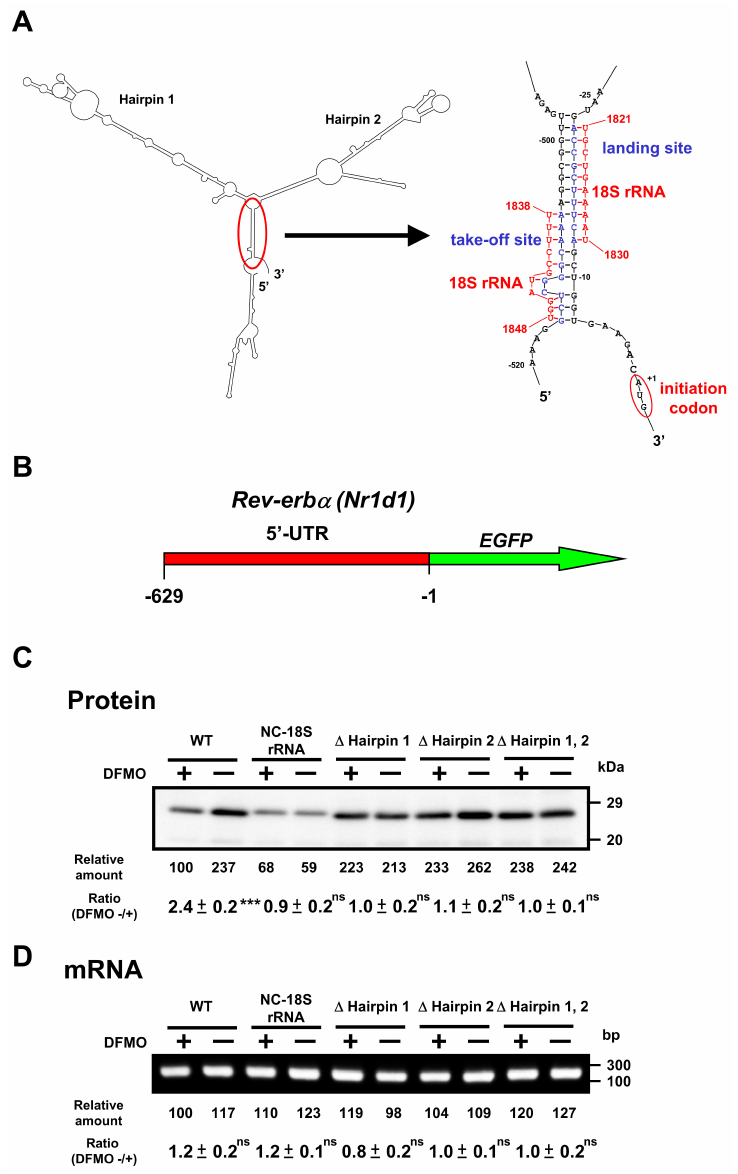
Figure 6. Effect of polyamines on the synthesis of REV-ERB α -EGFP derived from normal and modified Rev-erb α -EGFP mRNAs in NIH3T3 cells. Experiments were performed as described in the legend to Figure 5. ( A ) Optimal computer folding of the 5 (cid:48) -untranslated region (UTR) of Rev-erb α mRNA was performed by the method of Zuker [26]. Candidates for take-off and landing sites, which are complementary sequence to 18S rRNA are shown in blue, together with the sequence of 18S rRNA in red. ( B ) Structures of Rev-erb α -EGFP fusion genes are shown. ( C , D ) The levels of protein and mRNA were measured by Western blotting and RT-PCR, respectively. Rev-erb α -EGFP fusion gene encoding normal and modified 5 (cid:48) -UTR of Rev-erb α mRNA and full length of EGFP protein was transfected into NIH3T3 cells. ns p ≥ 0.05; *** p <